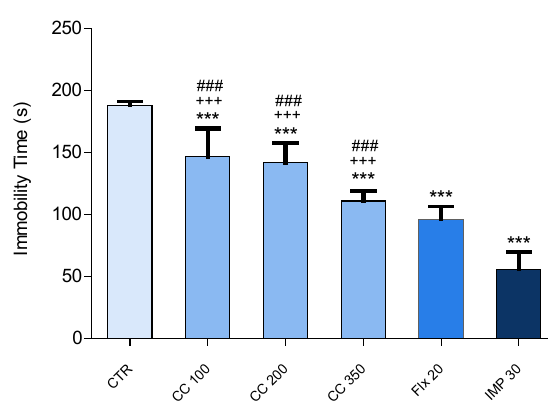
Figure 2. The Effects of the Intraperitoneal Administration of the CC Essential Oil, Fluoxetine, and Imipramine on the Mean Immobility Time in the TST. Note . Values are presented as mean ± SD. Significant differences between the groups were assessed using the one-way ANOVA, followed by Tukey’s test. *** shows significant differences between the vehicle (control) group at P < 0.001 in immobility time. Further, +++ shows significant differences between the CC group and fluoxetine at P < 0.001 in immobility time. ### represents significant differences between the CC group and imipramine at P <